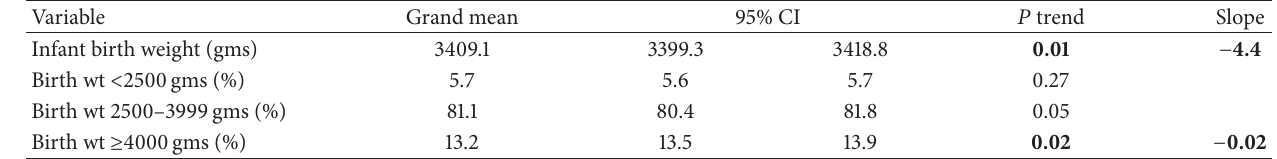
Table 7: Birth weight distribution for infants born in Maine, 2000–2010.